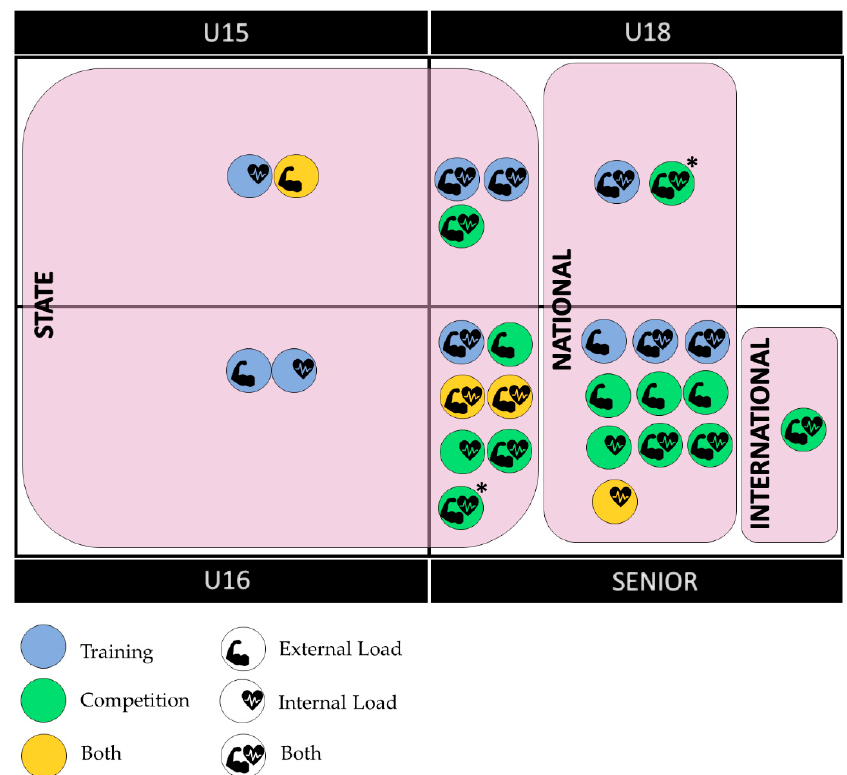
Figure 3. Grouping of the articles reviewed. Category (u15, u16, u18, senior); Level (state, national, international); Goal (Training, competition, both); Load (Internal, external, both). * In the same, there are u18 and senior samples.